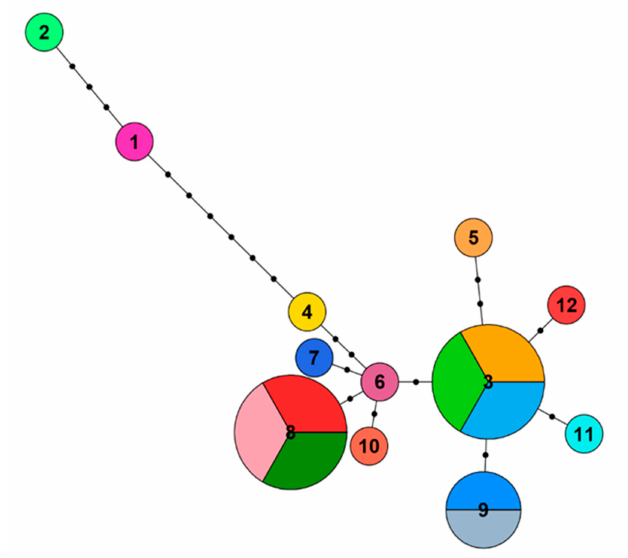
Figure 2. Haplotype network of the mitochondrial DNA control region for 17 captive water voles at Wildwood Trust. Each pie chart represents a unique haplotype and each colour represents a different individual. The dotted lines represent the number of mutational steps between haplotype sequences.